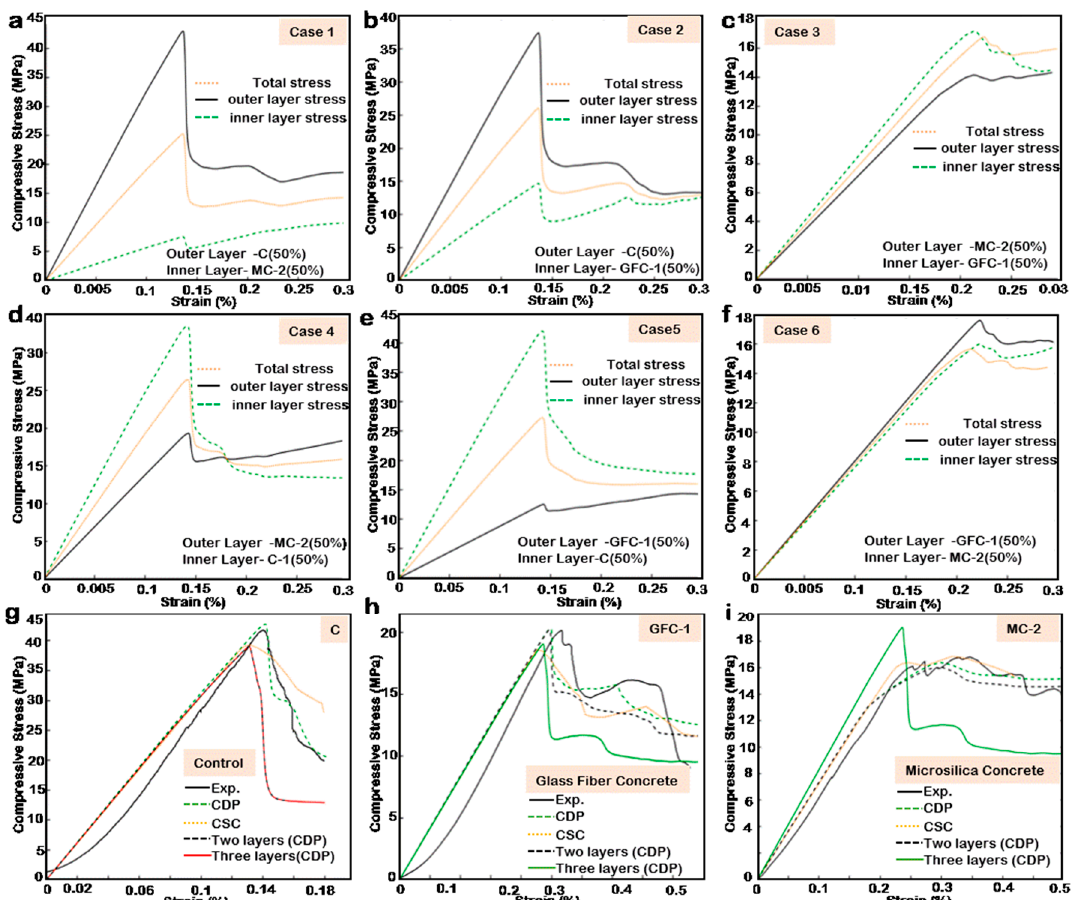
Figure A3. Numerical stress–strain curve of a two-layer configuration showing stress contribution from the inner and outer layers in ( a ) Case 1, ( b ) Case 2, ( c ) Case 3, ( d ) Case 4, ( e ) Case 5, and ( f ) Case 6. Effect of the “tie-constraint” interlayer boundary condition on ( g ) Control sample, ( h ) GFC-1, and ( i ) MC-2.